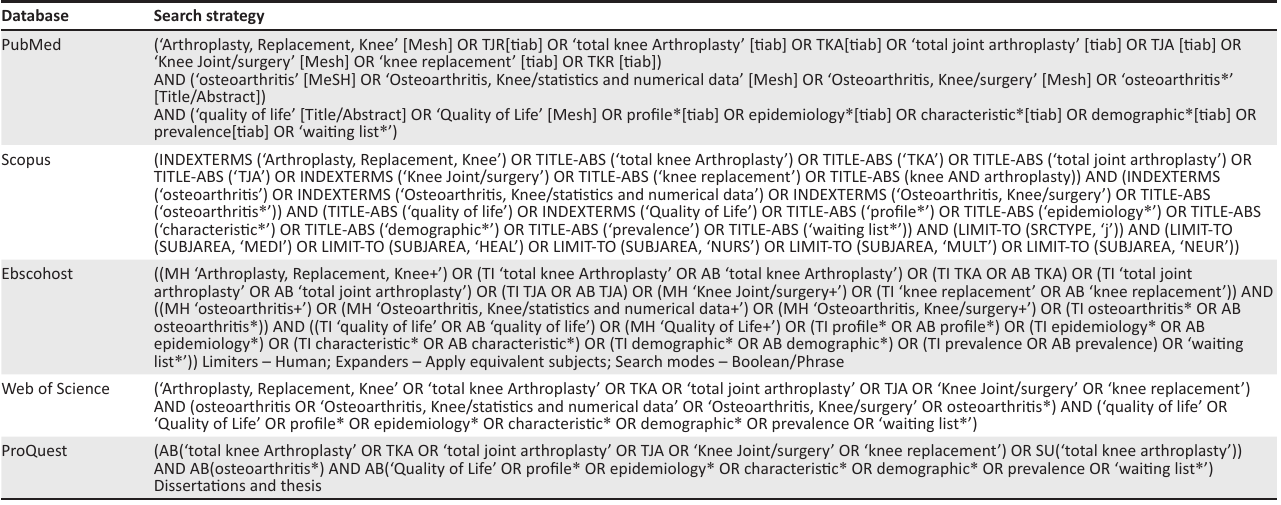
TABLE 2: Proposed search strategy for databases. Database Search strategy